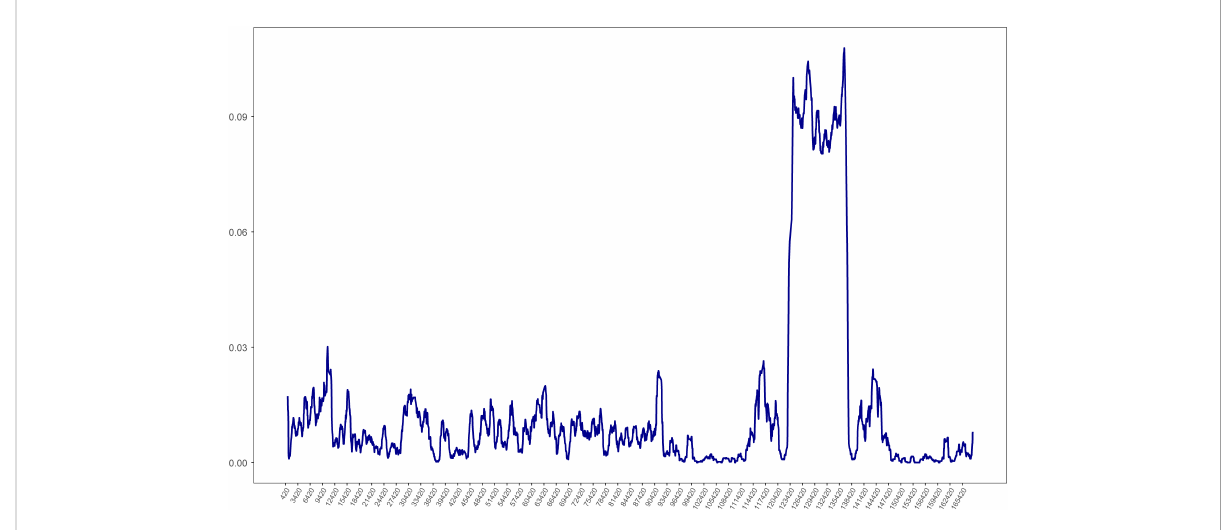
FIGURE 8 Chloroplast genome comparative analysis between I. pes-caprae and other 11 Ipomoea species. Sliding window plots of nucleotide diversity ( p ) across the complete cp genomes of I pes-caprae and other 11 Ipomoea species (window length: 600 bp, step size: 100 bp). Y-axes: nucleotide diversity ( p ) of each window; X-axes: the position of the midpoint of a